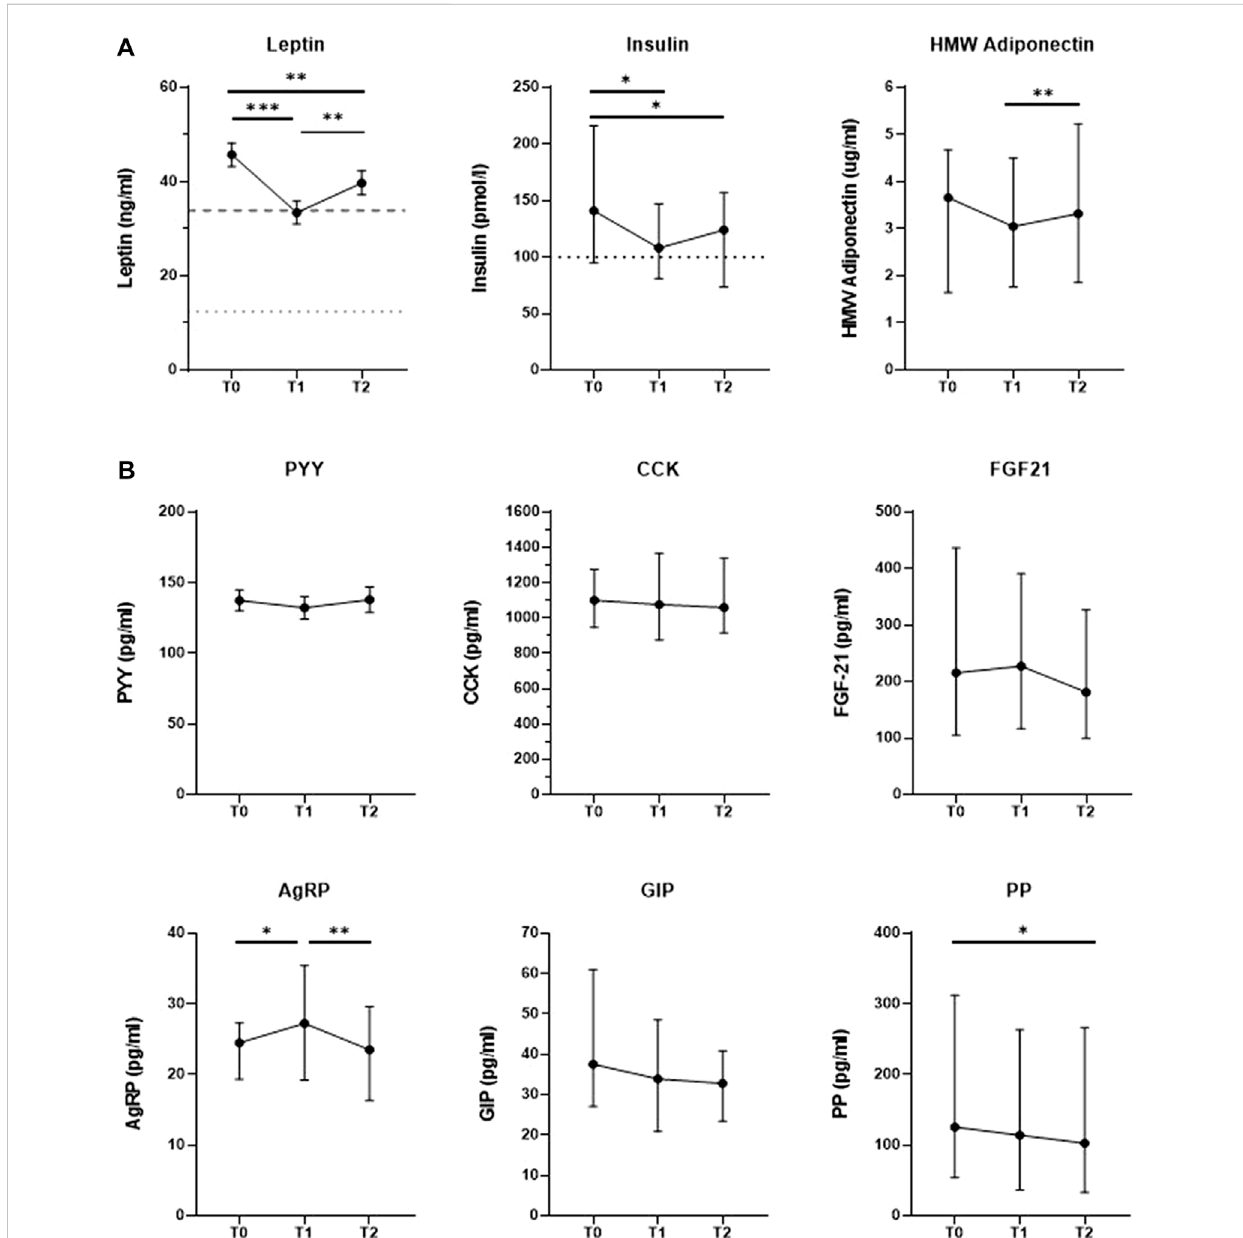
FIGURE 1 Changes in in levels of hormones regulating appetite and energy homeostasis in response to a combined lifestyle intervention from baseline (T)) to 10 weeks (T1) and 1.5 years of treatment (T2). (A) Changes in levels of long-term adiposity-related hormones, including decreases in leptin and insulin levels towards normal levels. Cut-off lines: Upper limit of reference range for healthy populations (dotted lower line: males: 0.2 – 12.4 ng/ml; dashed upper line: females: 1.5 – 33.9 ng/ml), as used for clinical diagnostics in the Erasmus MC. Cut-off line insulin: Upper limit of reference range for healthy populations ( ≤ 100 pmol/l for both sexes) as used for clinical diagnostics in the Erasmus MC. N-37 – 39. Data are expressed as mean + / - SD SEM ( leptin ) or median (IQR) (insulin, HMW adiponectin), depending on normal distribution. HMW Adiponectin = High molecular weight adiponectin./. (B) No change in levels of most short-term regulators of energy balance at the end of CLI. PYY = Peptide tyrosine-tyrosine-tyrosine, CCK = Cholecystokinin, FGF21 = Fibroblast growth factor 21, AgRP = Agouti-related protein, GIP = Gastric-inhibitory polypeptide, PP = Pancreatic polypeptide. Data are expressed as mean+/-SD SEM (PYY) or median (IQR) (PP, AgRP, GIP, PYY, CCK, FGF-21), depending on normal distribution. *p < .05, **p < .01, ***p < .001afterrepeated-measuresANOVAwithBonferroni-correctedposthoctestorFridman ’ stestwithBonferroni-correctedposthoctestsincaseofnon- normality. N = 38 –